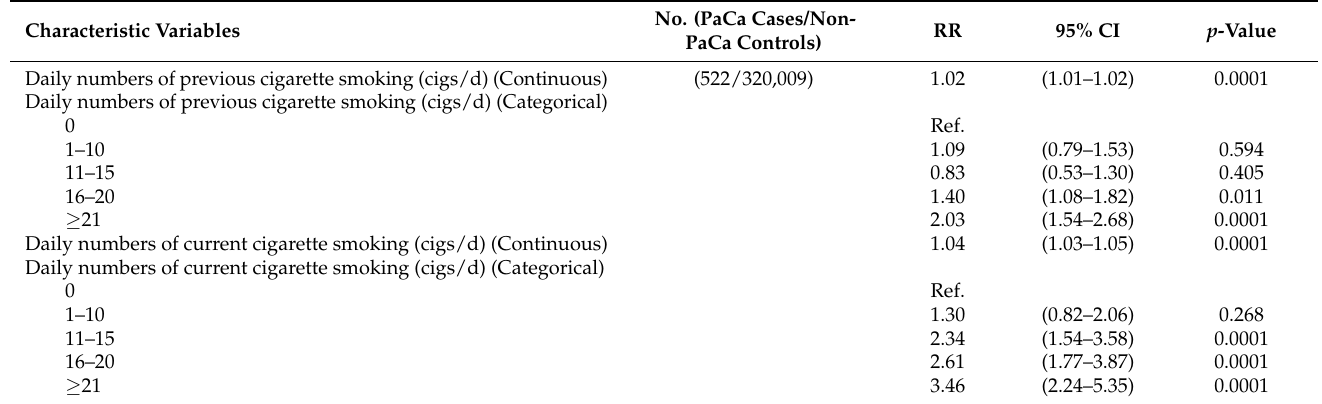
Table 3. Pancreatic cancer (PaCa) relative risk (RR) of different daily cigarette smoking numbers. among former and current smokers.